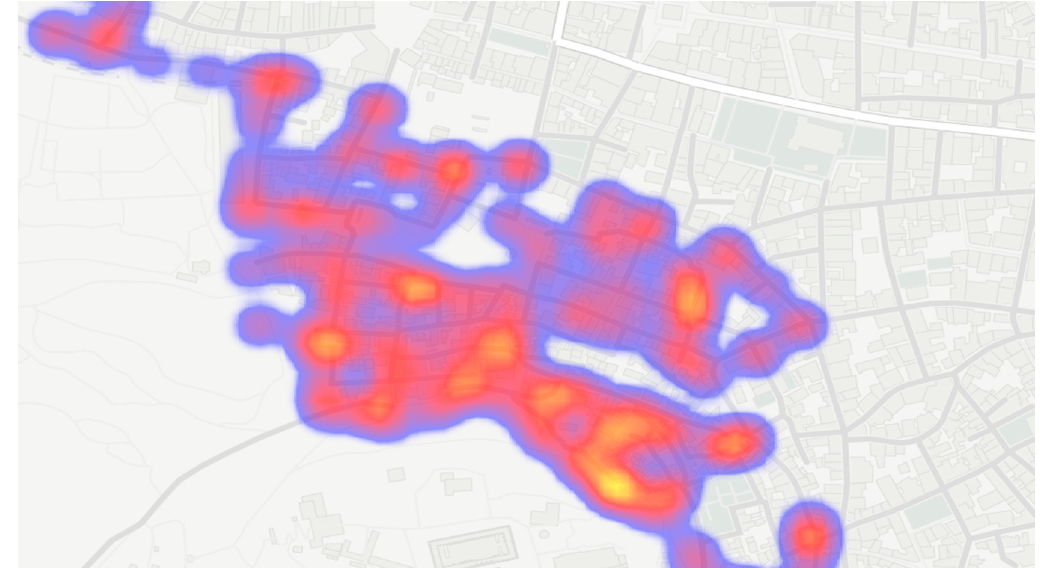
Figure 16. Heat map of relative measurement density.